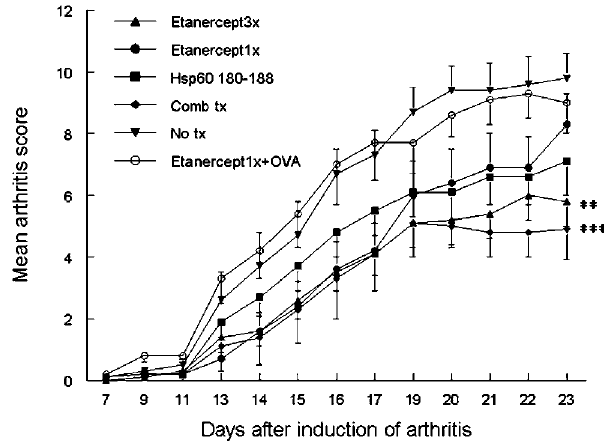
Figure 1. Combination therapy of Etanercept with mycobacterial heat shock protein 60 (HSP60) 180-188 led to significant reduction of Adjuvant Arthritis (AA). Arthritis was induced on day 0 with Complete Freund’s Adjuvant (CFA). On day 9, rats were randomly divided into five treatment groups: three doses of Etanercept s.c. on day 9, 11, 13 (equivalent to a full course of Etanercept treatment); one dose of Etanercept on day 9; four doses of mycobacterial HSP60 peptide 180- 188 on day 10, 13, 16, 19; combination treatment of one dose of Etanercept s.c. on day 9 followed by 180-188 nasally on day 10, 13, 16, 19; or no treatment (PBS). Arthritis scores were assessed every other day from day 8 onward. N=15–18 rats per treatment group. Shown are mean arthritis scores.